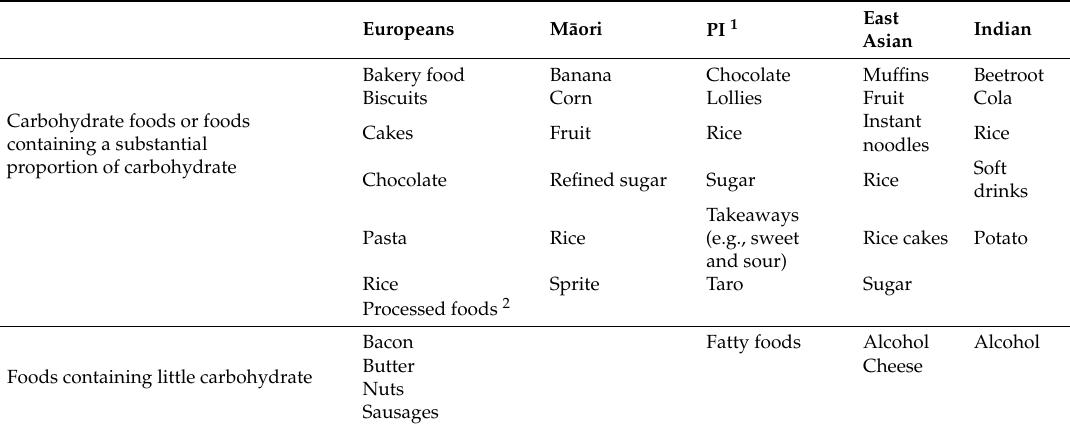
Table 2. Foods thought by participants to affect blood